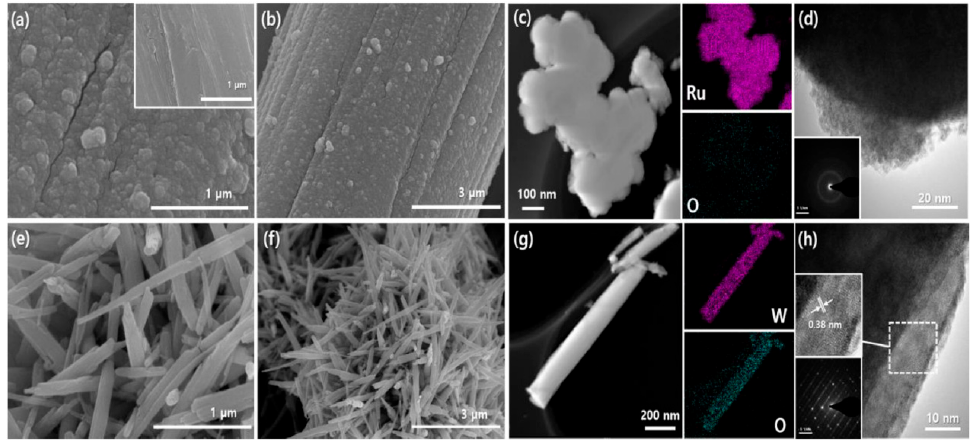
Figure 2. ( a , b ) Inset of ( a ) FE ‐ SEM images of hydrous RuO 2 on carbon cloth at different magnifications; ( c ) TEM image of the hydrous RuO 2 and its EDS mapping; ( d ) HRTEM image of hydrous RuO 2 and its SAED pattern in the inset of ( d ); ( e , f ) FE ‐ SEM images of h ‐ WO 3 on carbon cloth at different magnifications; ( g ) TEM image of the h ‐ WO 3 nanorod and its EDS mapping; ( h ) HRTEM image of h ‐ WO 3 nanorod. The inset shows the SAED pattern, reproduced with permission from [72] Copyright 2019 Elsevier. FE ‐ SEM, field emission scanning electron microscopy. TEM, transmission electron micro ‐ scope. EDS, energy dispersive X ‐ ray spectroscopy. HRTEM, high resolution transmission electron microscope. SAED, se ‐ lected area electron diffraction.